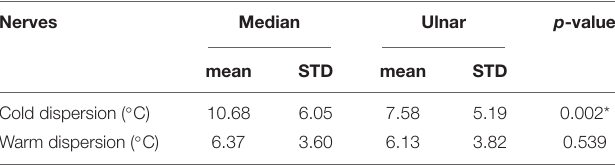
TABLE 5 | Dispersion (the temperature difference between feeling pain and temperature sensation) of low (cold) and high (warm) temperatures in the median and ulnar nerves. Left hand